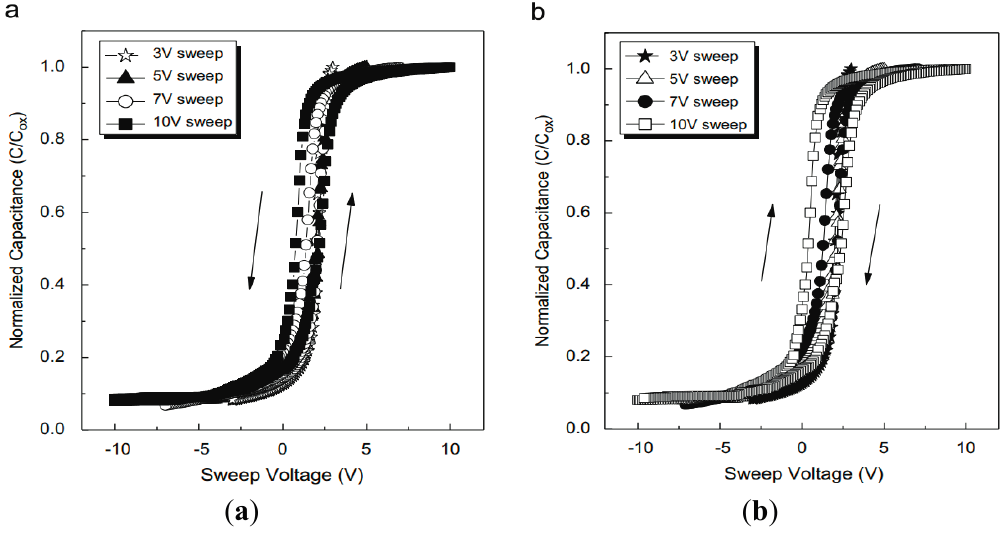
Figure 10. The C-V hysteresis of: ( a ) 5 nm and ( b ) 15 nm-thick Al O trap layer/5 nm Al O tunnel oxide structure as a function of the double-sweep the 5 nm La 2 3 2 3 voltage. Reused with permission from [49], Copyright 2010, Materials Science in Semiconductor